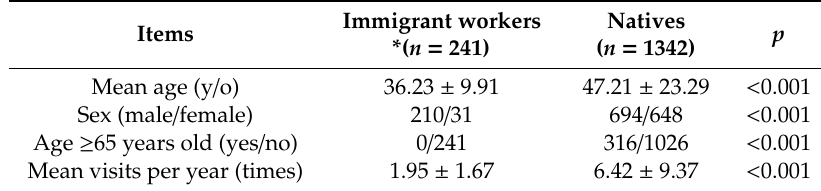
Table 1. Data on subjects ( n = 1583).